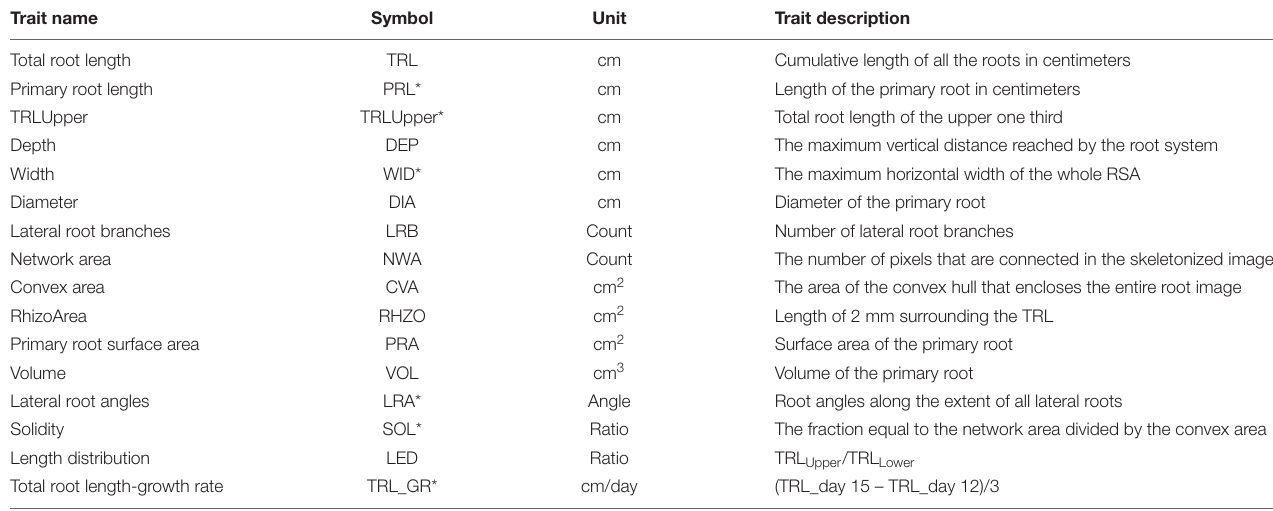
TABLE 1 | Subset of traits of mung bean root architecture extracted from the Automated Root Image Analysis (ARIA) software and used for the analysis, clustering, and iRoot